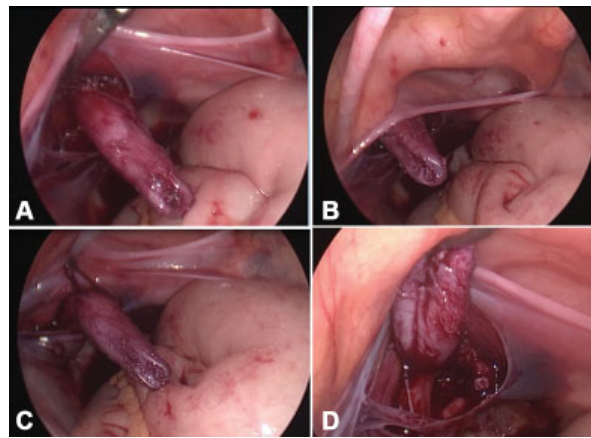
Fig. 2 The operative view showing ( A ) the retracted cystoscope within the prostatic utricle (PU), ( B ) PU below peritoneal re fl ection, ( C ) ligation of endoloop, and ( D ) PU after ligation and withdrawal of